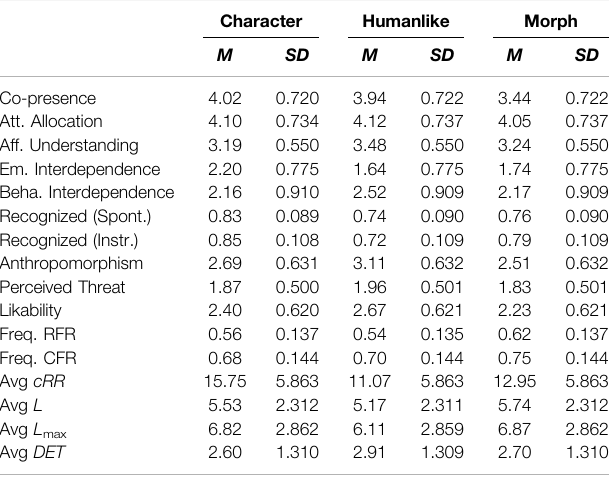
TABLE 4 | Descriptive Statistics of the 3x3 Mixed Measures ANOVAs per level of humanlikeness: Mean ( M ) and standard deviation ( SD ) of all dependent variables.